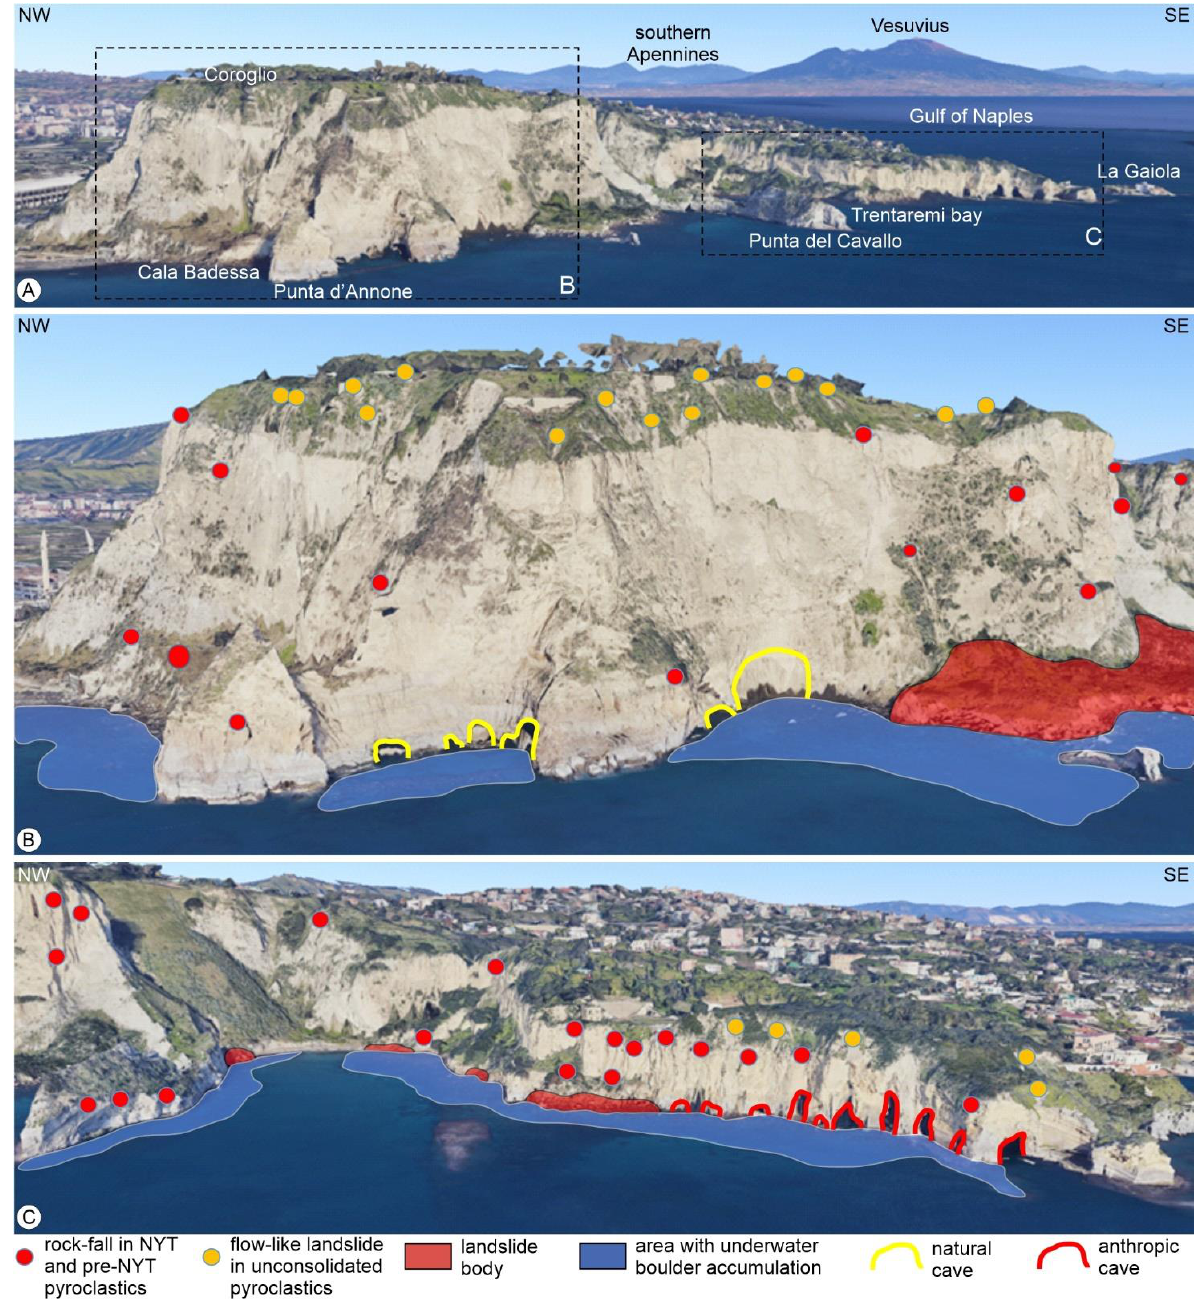
Figure 7. ( A ) Google Earth 3D views of the Coroglio-Trentaremi coastal sector. ( B ) Detail of the Coroglio sea cliff. ( C ) Detail of the Trentaremi sea cliff.